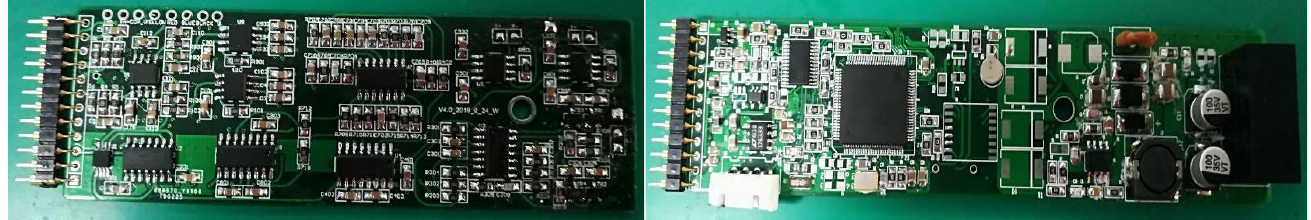
J. Mar. Sci. Eng. 2023 , 11 , x FOR PEER REVIEW Figure 9. Analog & Digital signal processing board. Figure 9. Analog & Digital signal processing board. Figure 9. Analog & Digital signal processing board.